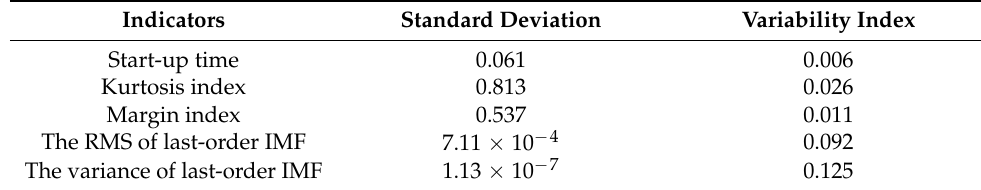
Table 8. The variability index of the